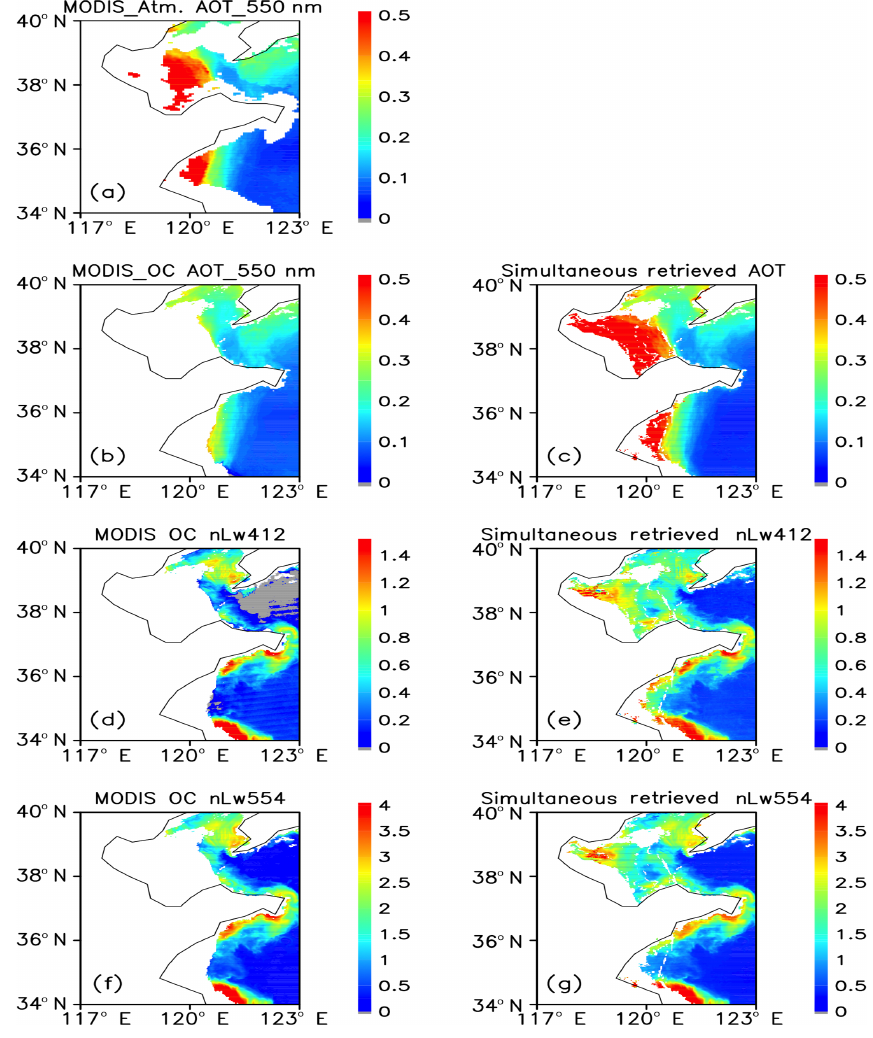
Figure 8. Comparison of simultaneously retrieved satellite AOT at 550nm and nL w (mwsr − 1 cm − 2 µm − 1 ) at 412 and 554nm with MODIS operational products over the East China Sea on 18 October 2011. (a) MODIS aerosol AOT products; (b, d, f) MODIS ocean color AOT and nL w products; (c, e, g) simultaneously retrieved AOT and nL w in this